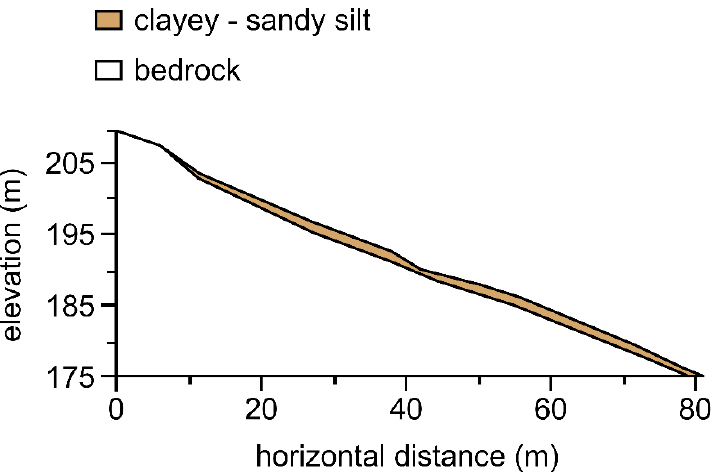
Figure 4. Geological model of the slope considered in the analysis (adapted from [44]).